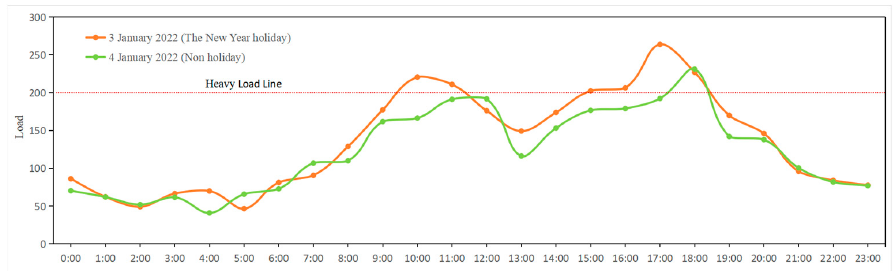
Figure 8. The load curve of a public transformer on New Year’s Day holiday and non